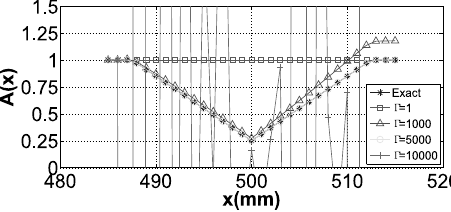
Fig. 3. Effect of the relaxation factor Γ on the solution with the LM method.